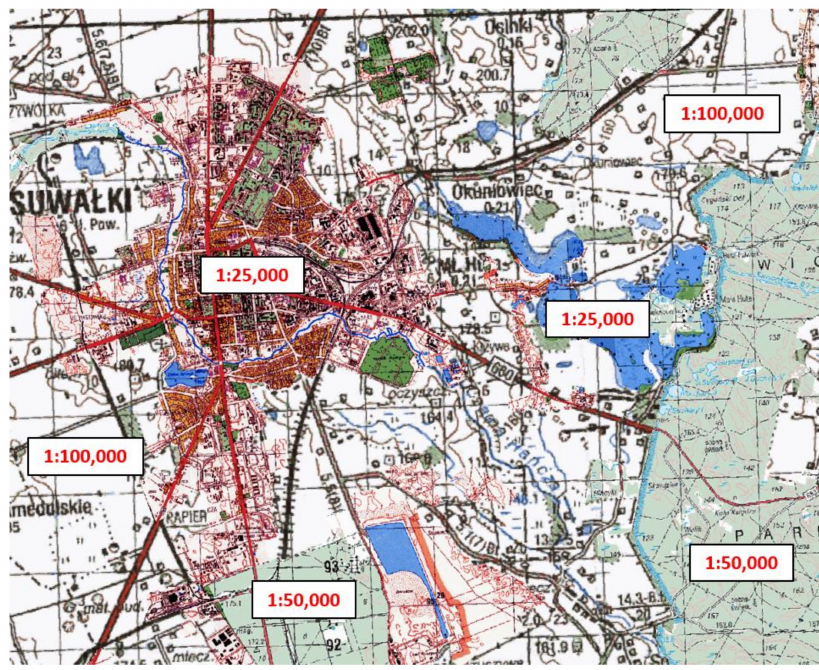
Figure 8. Fragment of the mosaic of raster maps in various